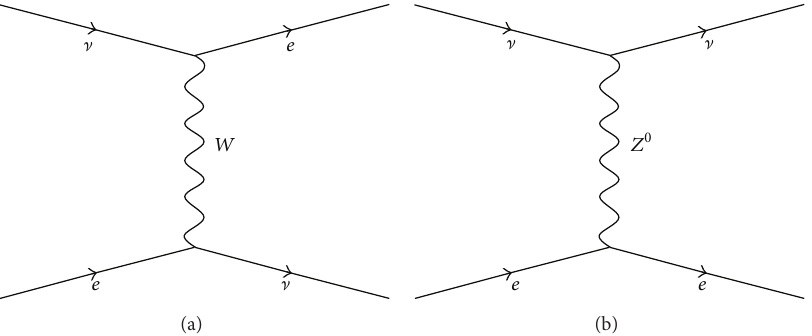
Figure 1: Elastic neutrino-electron scattering due to the weak interaction. Exchange by the 𝑊 (a) and 𝑍 0 (b) bosons is shown.